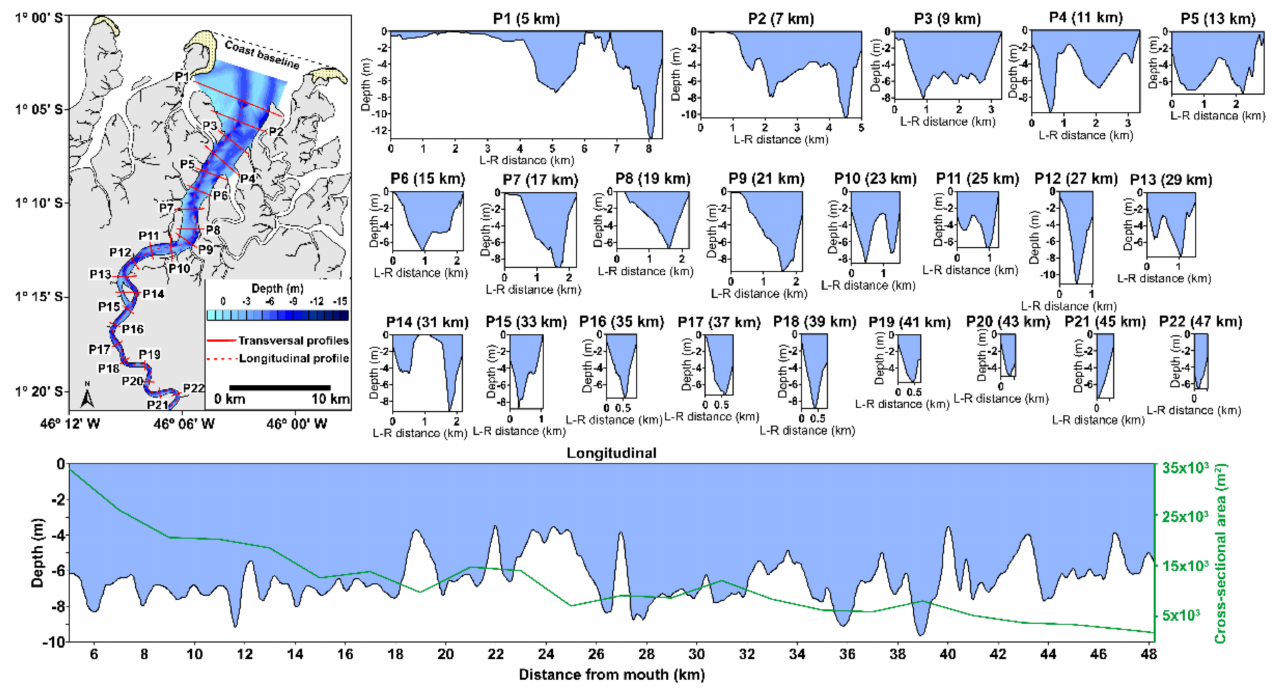
Figure 2. Bathymetric profiles showing the morphology of the Gurupi estuary. The red lines show the location of the transect. The green line shows the variation of the cross-sectional area along the estuary. Seasonal bottom morphology changes are not